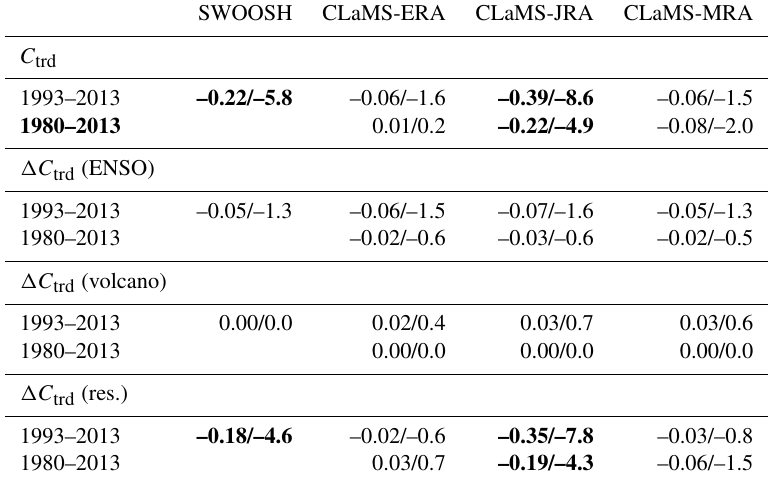
Table 1. Trend estimates in H 2 O entry mixing ratios and contributions from different sources of variability based on the three CLaMS simulations and SWOOSH over the SWOOSH period (1993–2013) and the longer CLaMS period (1980–2013). Trends are reported in units of parts per million by volume per decade (left of the slash) and percent per decade (right of the slash). Statistically significant trends are marked in